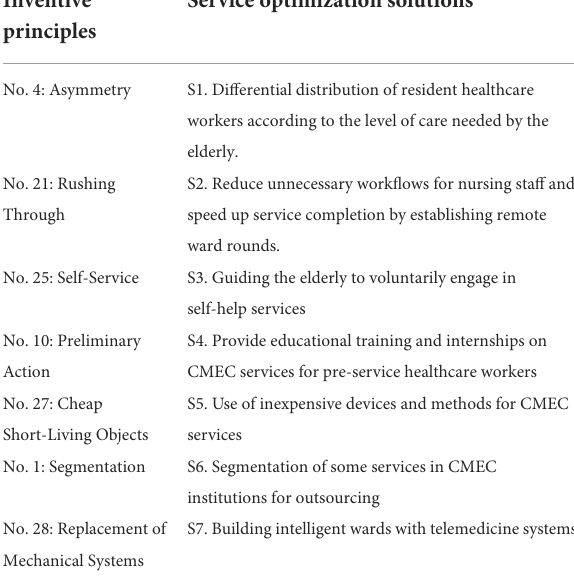
TABLE 13 Translation of TRIZ principles into service optimization